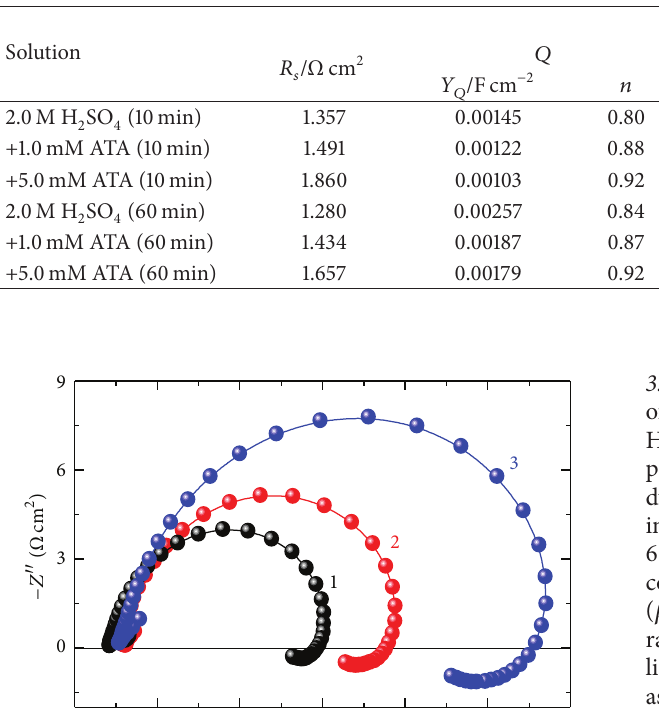
SO solutions. 2 4